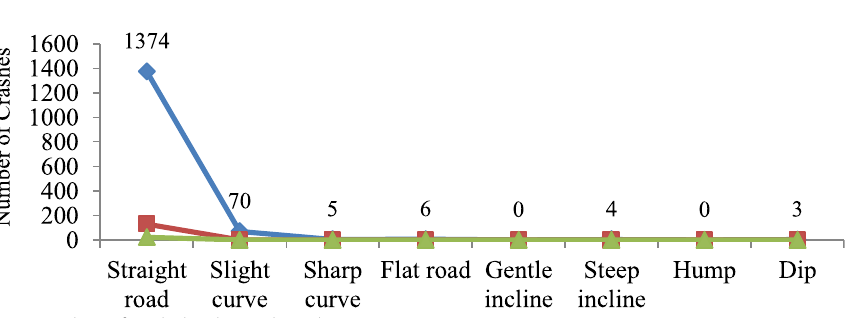
Fig. 6 Analysis of crash data by road